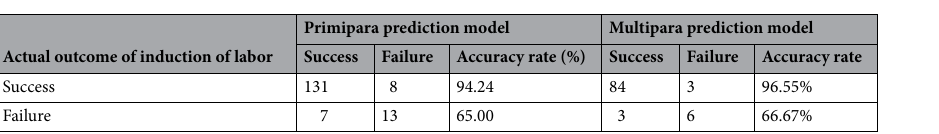
Table 4. External verification results of prediction